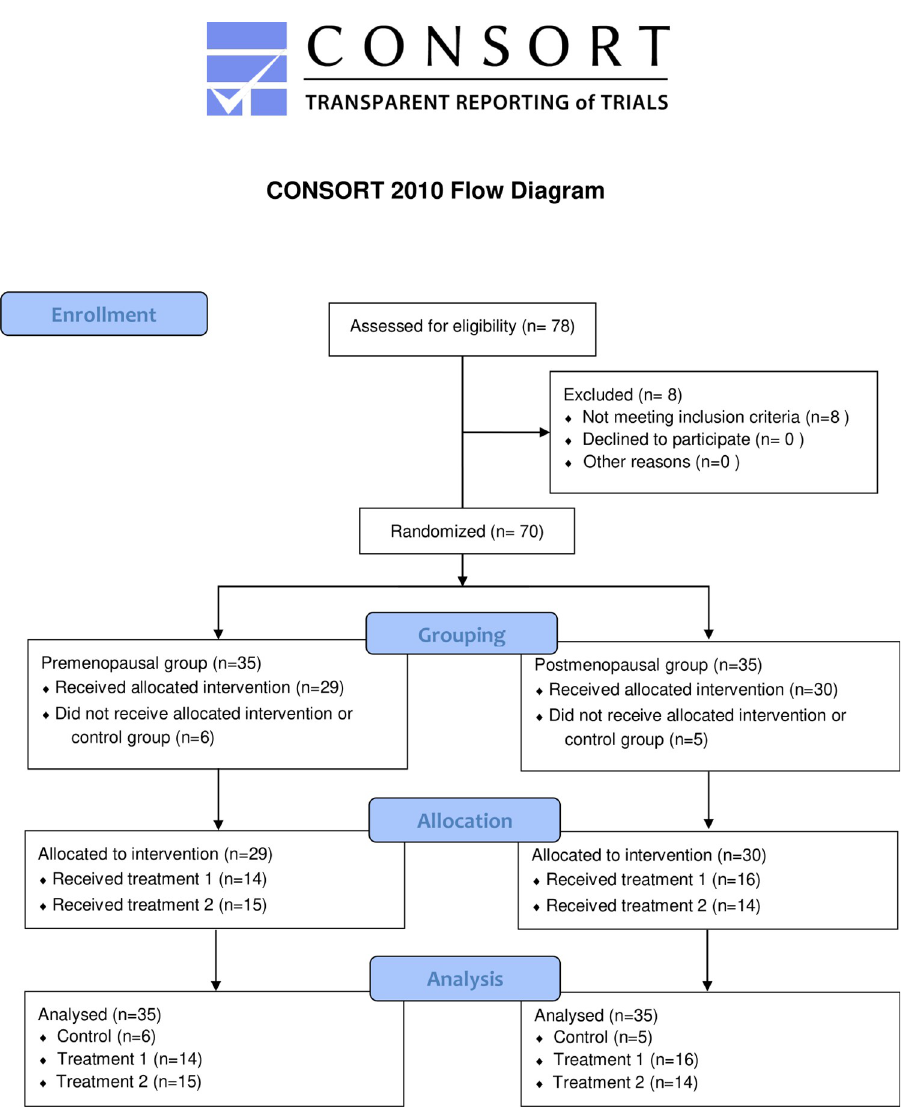
Fig 1. CONSORT flow